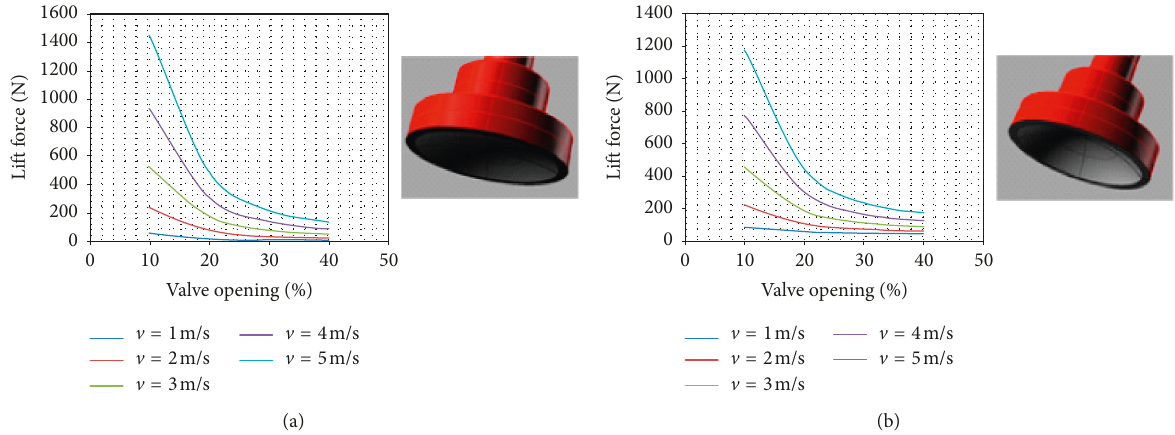
Figure 15: Relation between lift force and valve opening at different inlet velocities for plug p1 (a) and p2 (b).